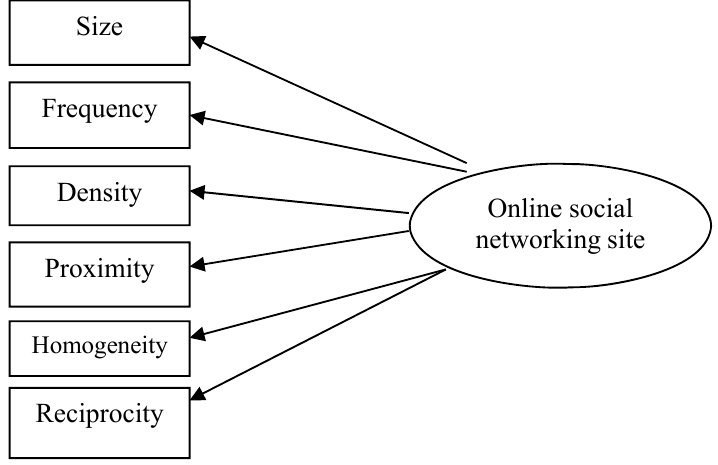
Fig. 1. Conceptual model of